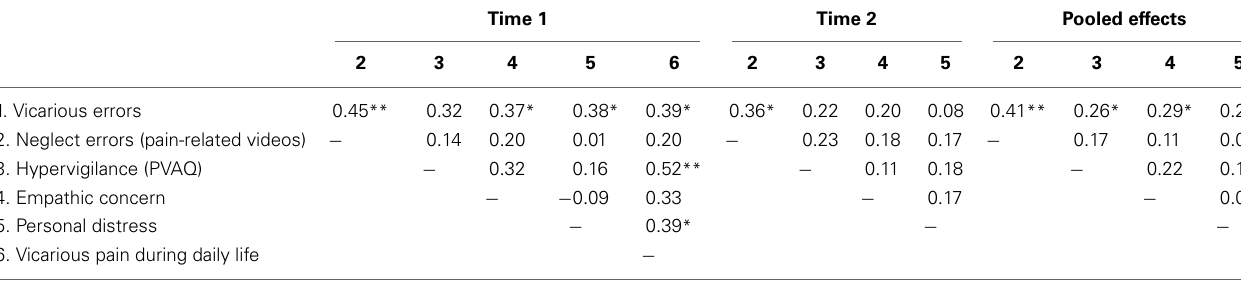
Table 2 | Pearson/Spearman correlations of all measures (T1, T2 and pooled effects).